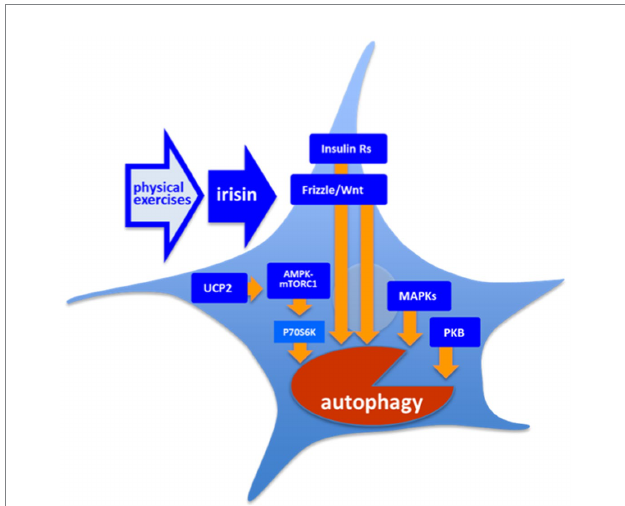
FIGURE 3 Molecular targets of irisin. There is a number of the intracellular cascades are shown to respond to irisin both in vitro and in vivo : However, the exact mechanism providing a coupling of free irisin and its intracellular targets is still unknown. AMPK, 5’ AMP-activated protein kinase; Frizzle/Wnt, key proteins of respective pathway; Insulin Rs, Trk insulin Receptors; mTORC1, mammalian target of rapamycin complex 1; PKB, protein kinase B (Akt); and UCP2, uncoupled protein